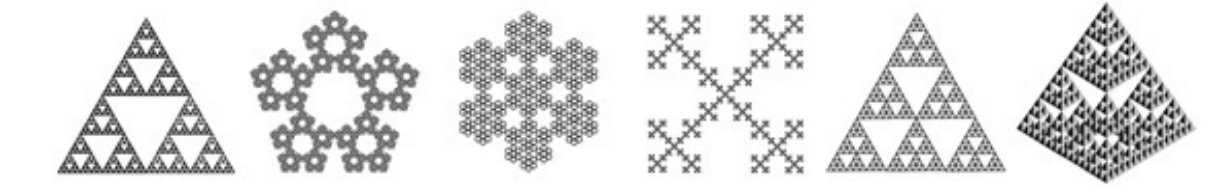
Figure 2. Fractals as pure mathematical shapes.